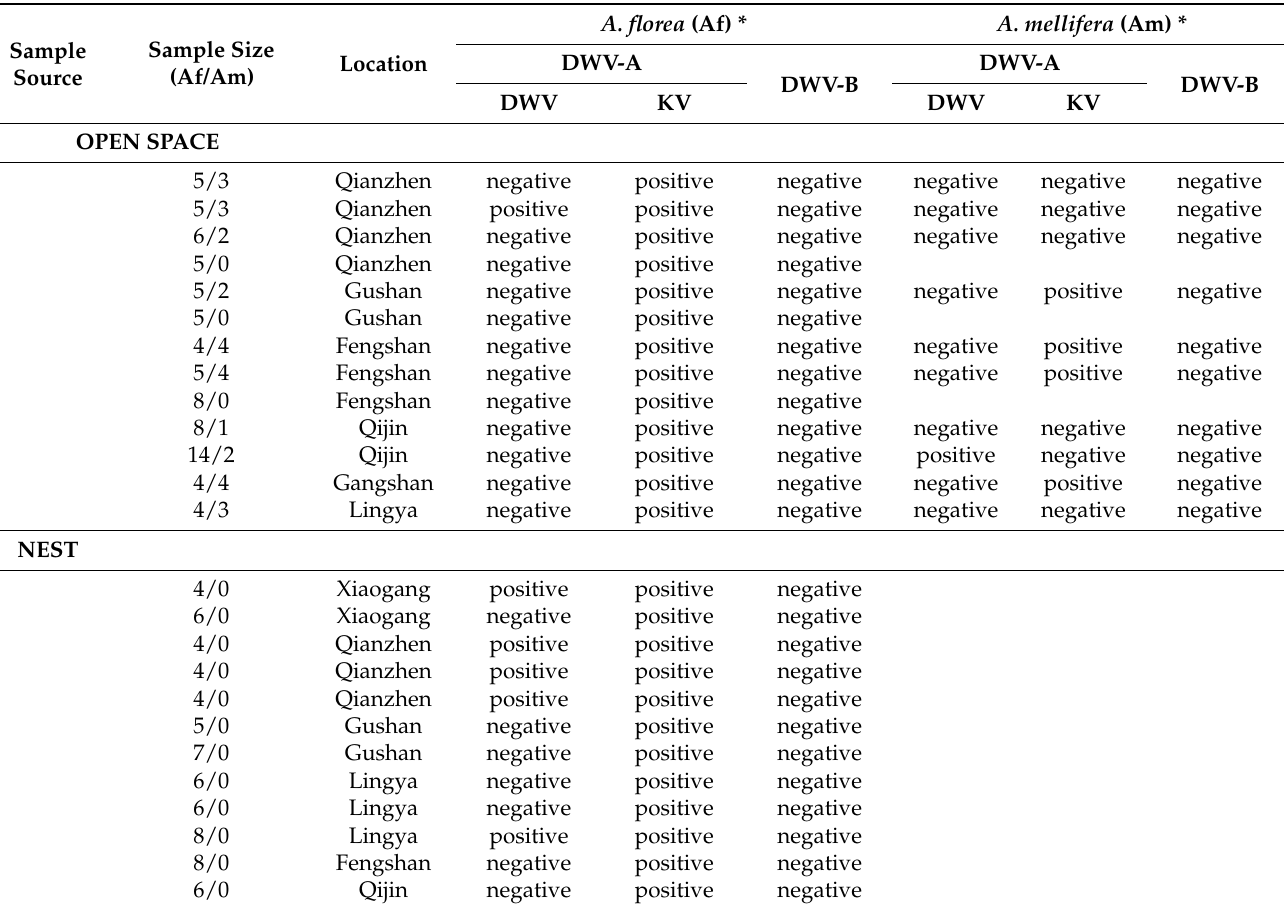
Table 3. Detection of DWV-A and DWV-B in workers of Apis florea and A. mellifera by RT-PCR.